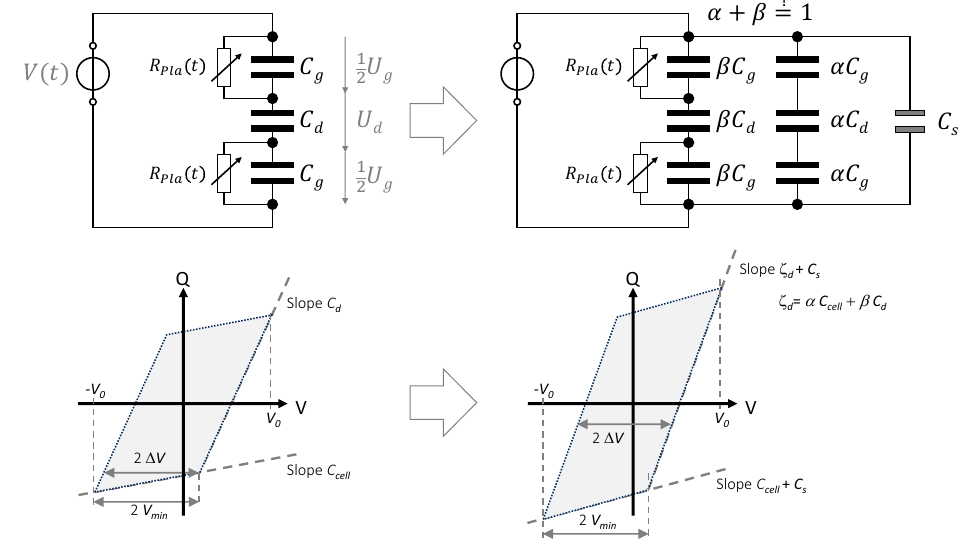
Figure 3. Simplest equivalent circuit of the DBD arrangement in Figure 1 (left) and its extension for non-uniform plasma and the presence of a parallel parasitic capacitance C s (right). Measured voltages are symbolized by V .. while apparent voltages by U ..